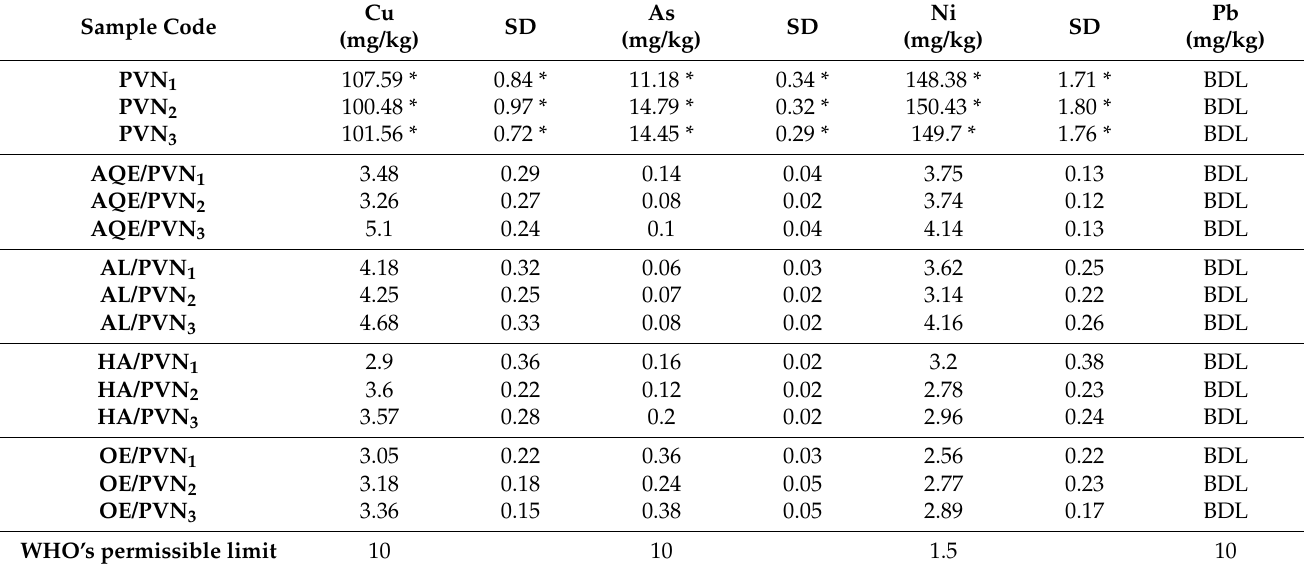
Table 5. Analyses of Phoradendron villosum and extracts determined by EDXRF. BDL: below detection limit. ANOVA p < 0.05 * significant difference, post hoc Tukey’s.